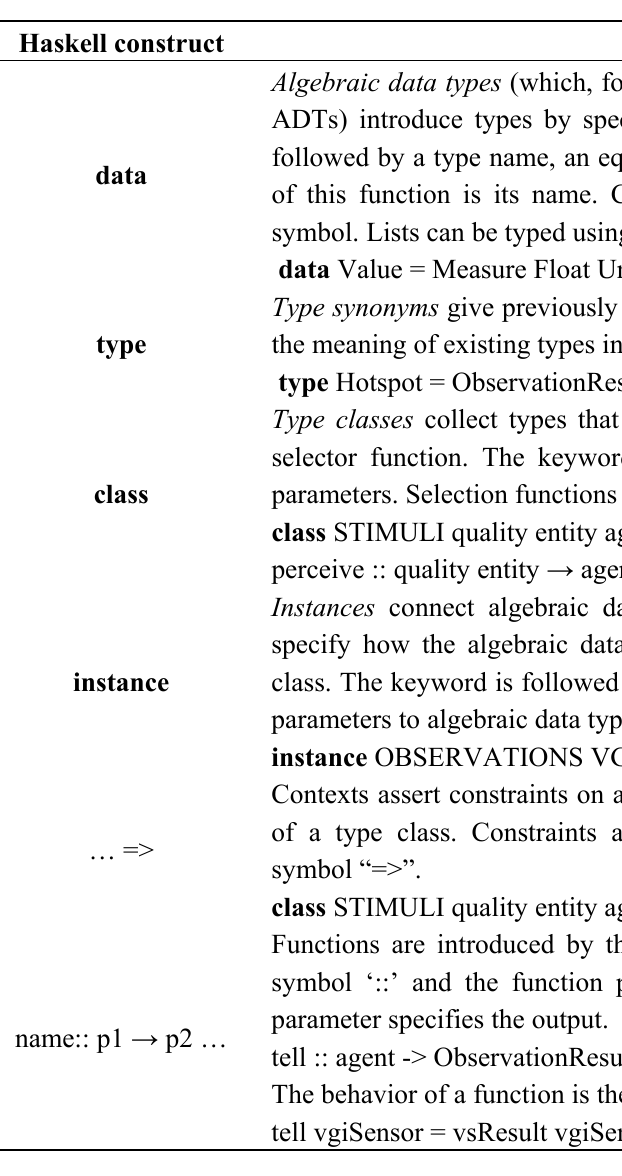
Table 3. Overview of required Haskell